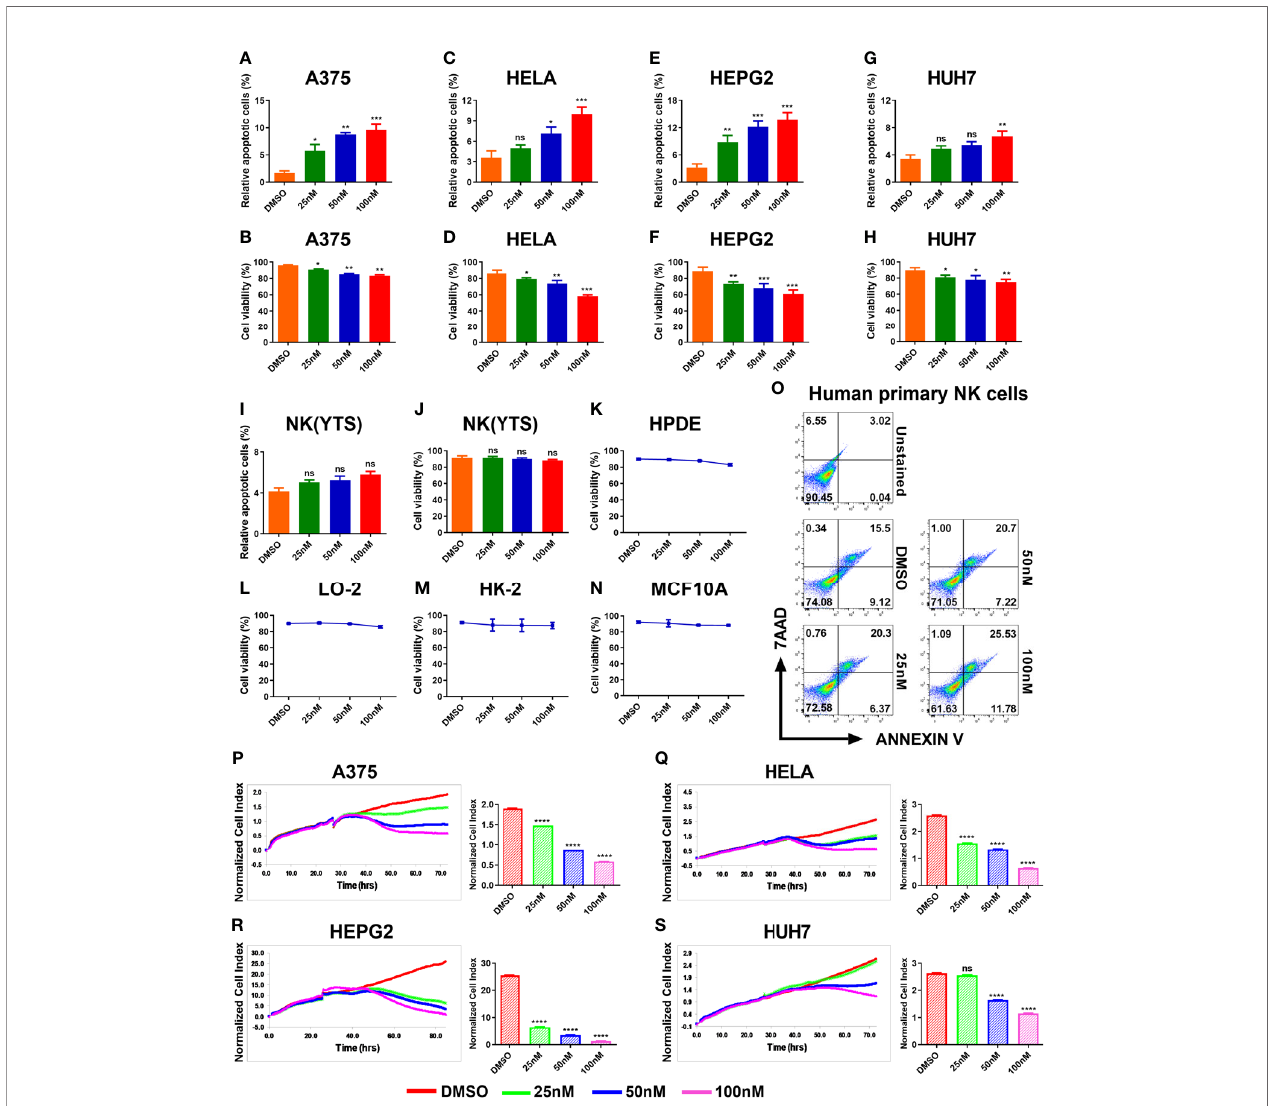
FIGURE 1 | HDACi (Panobinostat) showed anti-tumor and anti-proliferative activity on tumor cells but has minimal effect on the viability of NK(YTS), normal human cell lines and primary human NK cells. Assessment of the in vitro panobinostat treatment on tumor cell viability. (A, C, E, G) apoptotic tumor cells; (B, D, F, H) viable tumor cells after 24 hours of increasing dose of panobinostat treatment with DMSO controls. (I, J) Evaluation of in vitro panobinostat treatment on NK (YTS), (K – N) normal human cell lines, and (O) primary human NK cells viability. Proliferation analysis of tumor cell growth treated with an increasing dose of panobinostat and DMSO control for the speci fi ed number of hours using the REAL-TIME Cell Analyzer (RTCA). (P – S) real-time proliferation pro fi les and statistical analysis of the normalized Cell Index (CI) for each proliferation pro fi le: (CI) represents several cellular parameters, such as cell number, cell size, and cell-cell attachment; increased CI value indicates cell growth. (A, B, P) human skin cell carcinoma A375, (C, D, Q) human cervical carcinoma HeLa, (E, F, R) human hepatocellular carcinoma HepG2, (G, H, S) human hepatocarcinoma Huh7, (I, J) clonal human NK cell line YTS, (K) Human Pancreatic Duct Epithelial, (L) Human Hepatic Cell Line, (M) Human Kidney cell line, and (N) Human Mammary Epithelial Cells. (A – S) Data represent mean ± SD (n =4 replicates) from three independent experiments. Statistical signi fi cance was assessed by t-test. (not signi fi cant ns P >0.05, *P ≤ 0.05, **P ≤ 0.01, ***P ≤ 0.001, ****P ≤